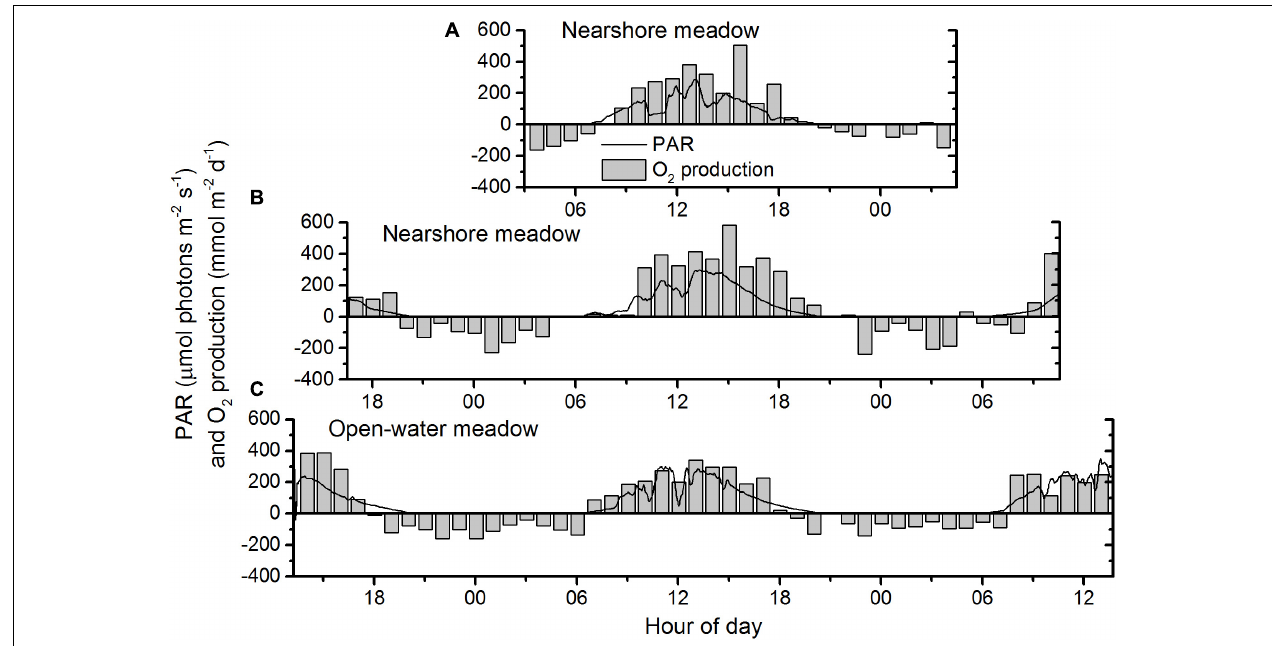
FIGURE 4 | Diel PAR and net photosynthesis (O 2 production > 0) and respiration (O 2 production < 0) at the nearshore meadow on (A) day one and (B) day two of data collection, and at (C) the open-water meadow over 2 days of continuous data collection.